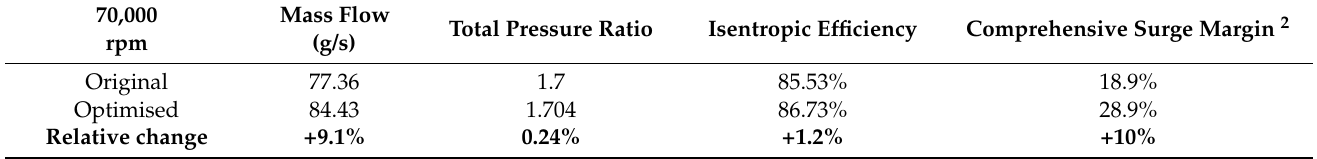
Table 7. Comparison of the performance at the design point before and after optimisation (rated operating condition).